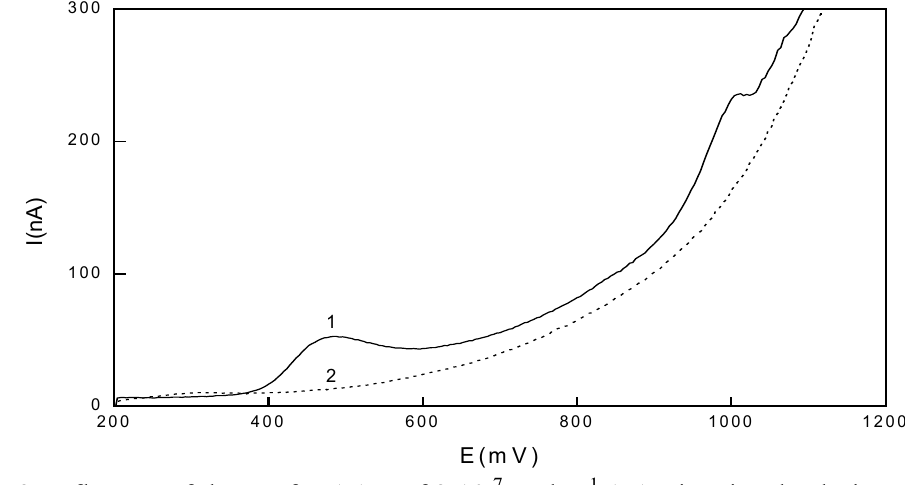
Figure 3. Influence of the t